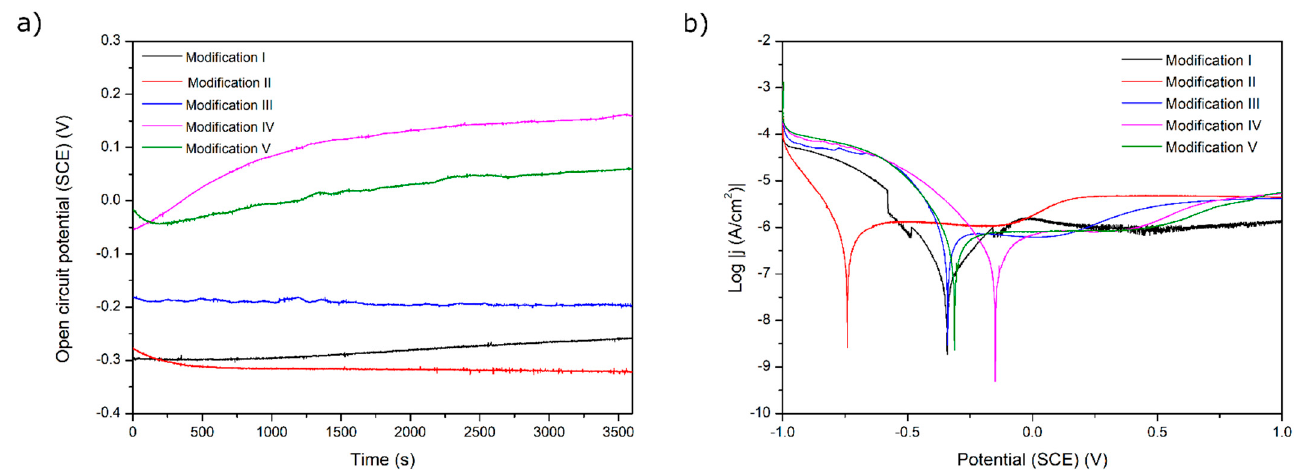
Figure 6. ( a ) Open-circuit potential vs. time and ( b ) potentiodynamic corrosion curves obtained for